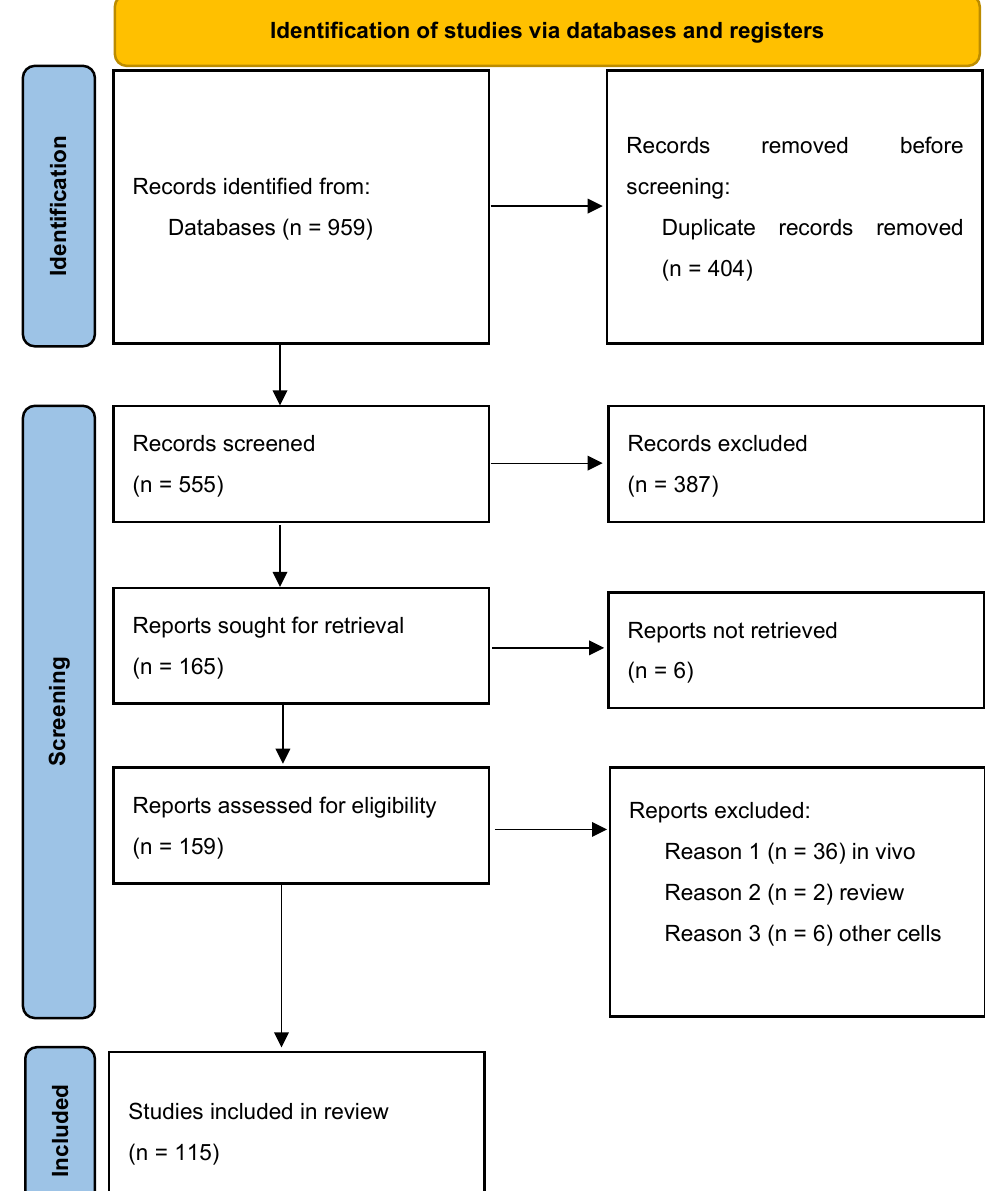
Figure 1. PRISMA flowchart describing data collection for this study.